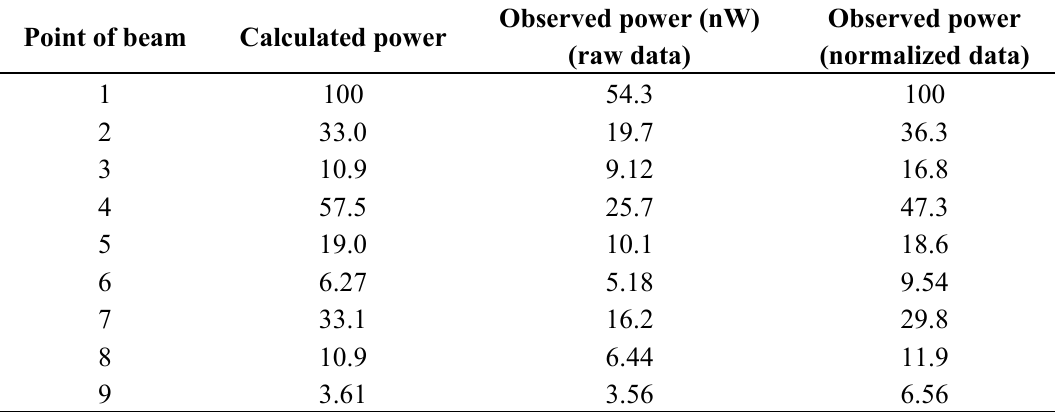
Table 2. Observed powers of the nine